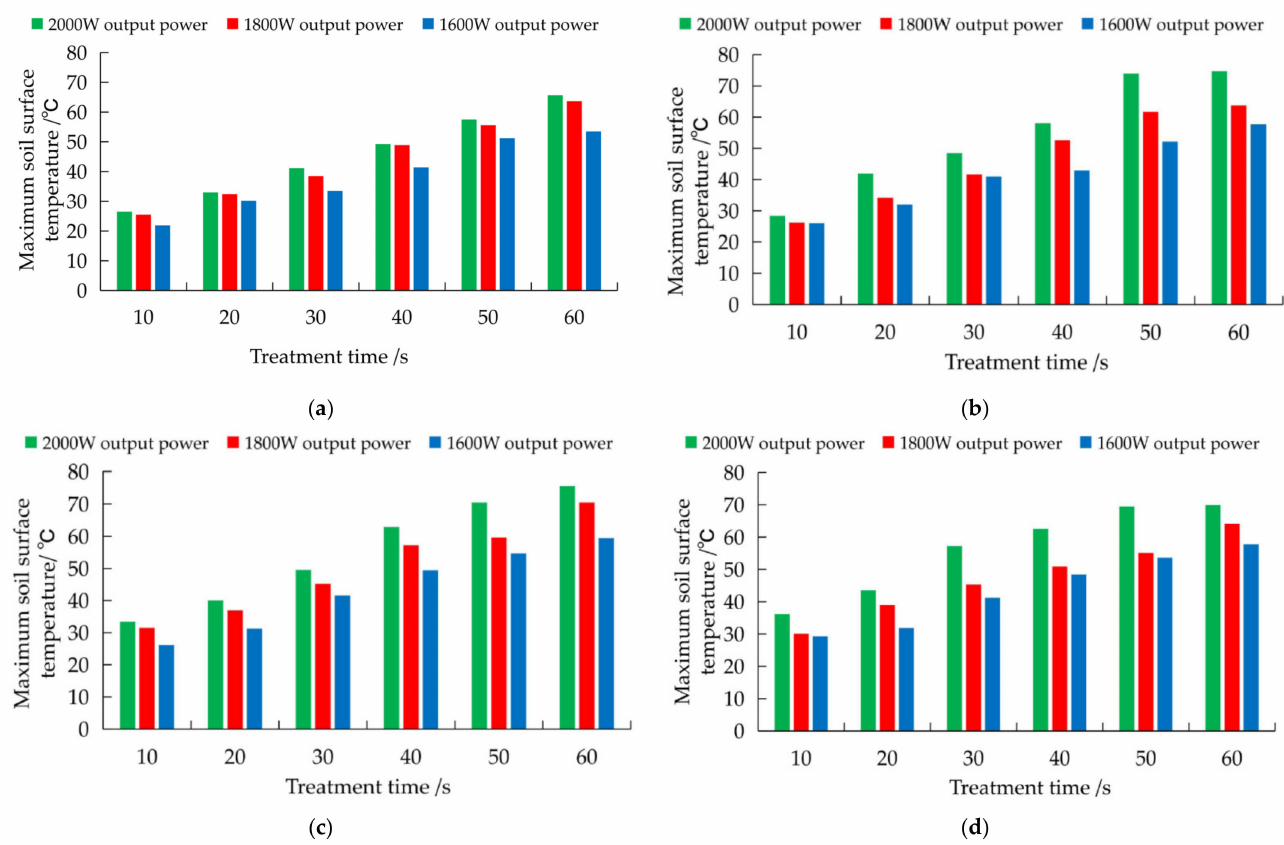
Figure 19. Effect of the microwave output power on the maximum soil surface temperature: ( a ) diagram of the treatment time and maximum soil surface temperature for a 0% soil moisture content; ( b ) diagram of the treatment time and maximum soil surface temperature for a 10% soil moisture content; ( c ) diagram of the treatment time and maximum soil surface temperature for a 20% soil moisture content; ( d ) diagram of the treatment time and maximum soil surface temperature for a 30% soil moisture